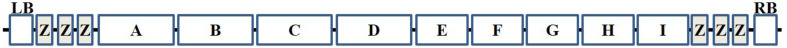
Schematic description of the “self-removable” CRISPR-Cas9 vector used for the transformation of the BY2 cells. LB, left border; ZZZ, three repeats of 23 nucleotides each used as a target for sgRNA-Z; Cassette A, (NosP-HptII-NosT); Cassette B, (35SP-hCas9-OcST); Cassette C, (35SP-codA-OcST); Cassette D, (HSP-sgRNA-Z-OcST); Cassette E, (U6-sgRNA1-5xT); Cassette F, (U6-sgRNA2-5xT); Cassette G, (U6-sgRNA3-5xT); Cassette H, (U6-sgRNA4-5xT); Cassette I, (U6-sgRNA5-5xT); RB, right border; NosP, Nopaline synthase promoter; HptII, Hygromycin phosphotransferase II; NosT, Nopaline synthase terminator; 35SP, 35S cauliflower mosaic virus promoter with omega enhancer; hCas9, human-optimized Cas9 with the SV40 nuclear localization signal; OcST, Octopinesynthase terminator; coda, Cytosine deaminase (negative selectable marker); HSP, heat shock promoter (HSP 18.2) from Arabidopsis thaliana; U6, Arabidopsis U6 promoter; sgRNA-Z, Chimera of crRNA directed to the Z sequences at the boundaries of the vector with tracrRNA; sgRNA 1-5, five chimeras of the five crRNAs with tracrRNA, that were used to knock out FucT and XylT genes (Hanania et al., 2017); and 5xT, terminator, five repeats of T.